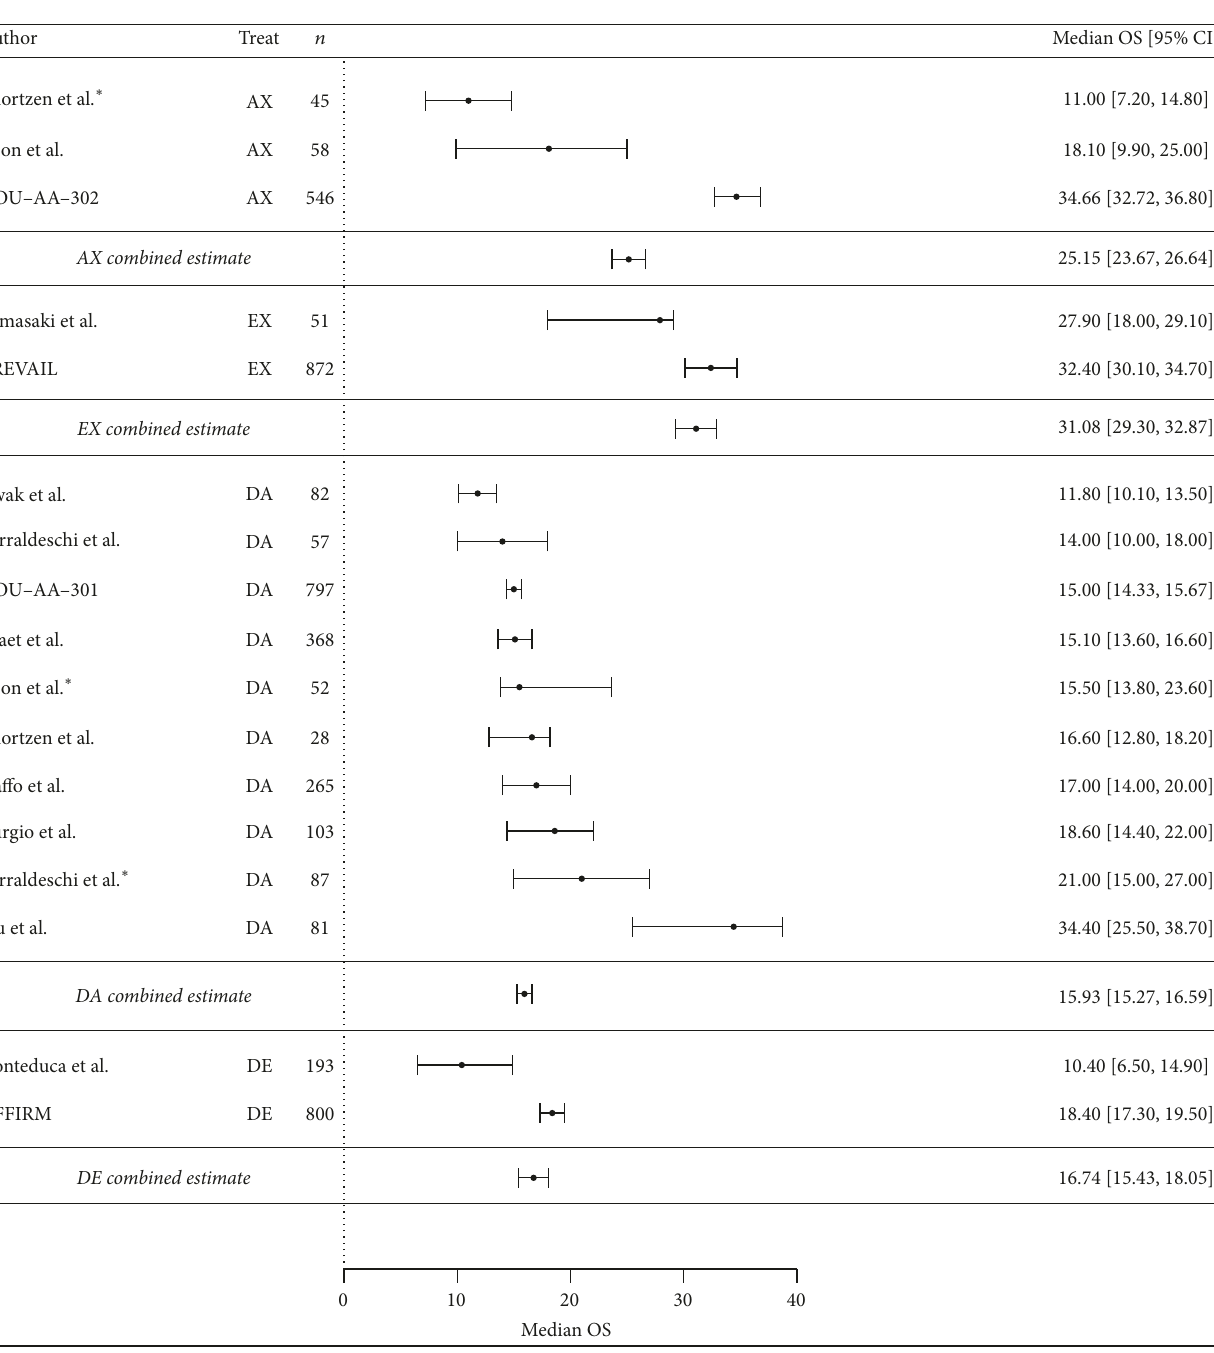
Figure 2: Forest plot depicting median OS (in months) of AX ( 𝑛 = 3 ), EX ( 𝑛 = 2 ), DA ( 𝑛 = 10 ), and DE ( 𝑛 = 2 ) cohorts. Open circles on confidence bounds denote studies that only provided the lower confidence